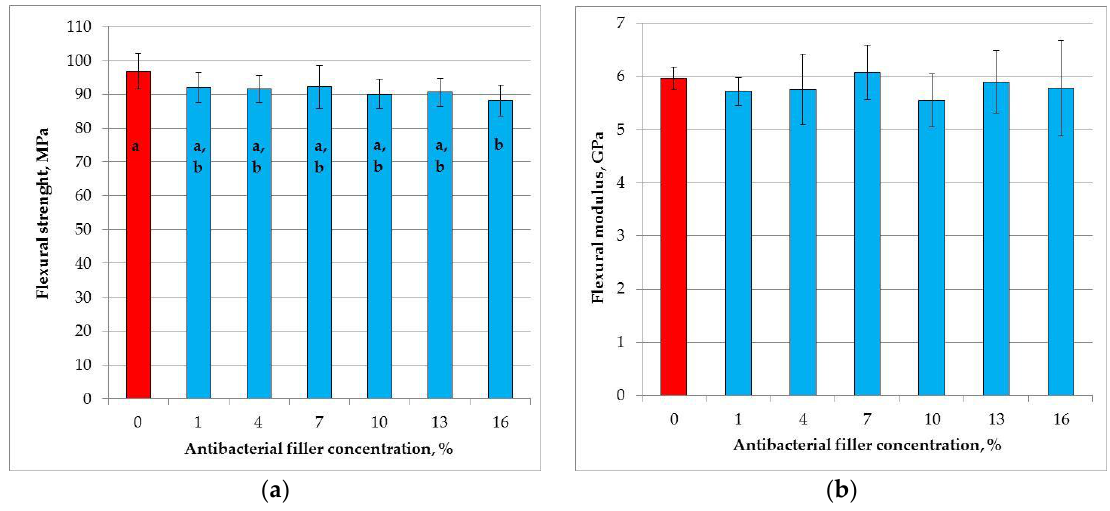
Figure 5. Mean flexural strength ( a ) and flexural modulus ( b ) values with standard deviations; different lowercase letters show significantly different results at the p < 0.05 level.